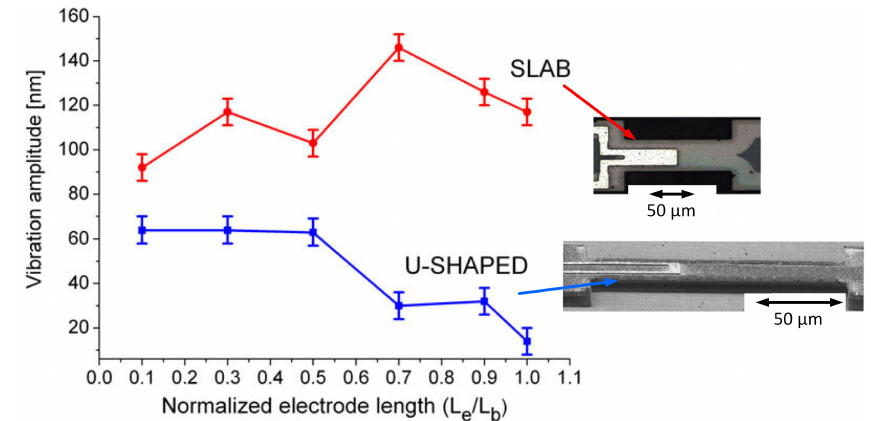
Figure 12. Optically-measured vibration amplitude at resonance as a function of electrode length, L e , for an electrothermally-actuated SiC bridge (DC bias voltage 1 V) with length, L b (inset: SEM images of fabricated devices with slab and u-shaped electrodes) [52]. Reprinted from Microelectron. Eng., 87, Mastropaolo et al., Electro-thermal behaviour of Al/SiC clamped-clamped beams, 573–575, c (cid:13) 2010, with permission from